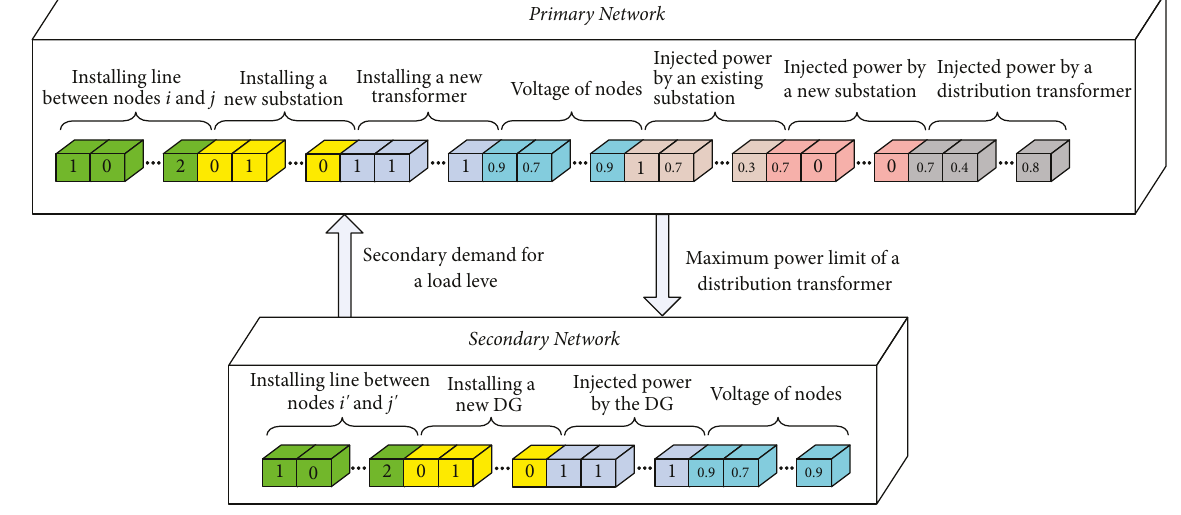
Figure 4: Structure of the proposed